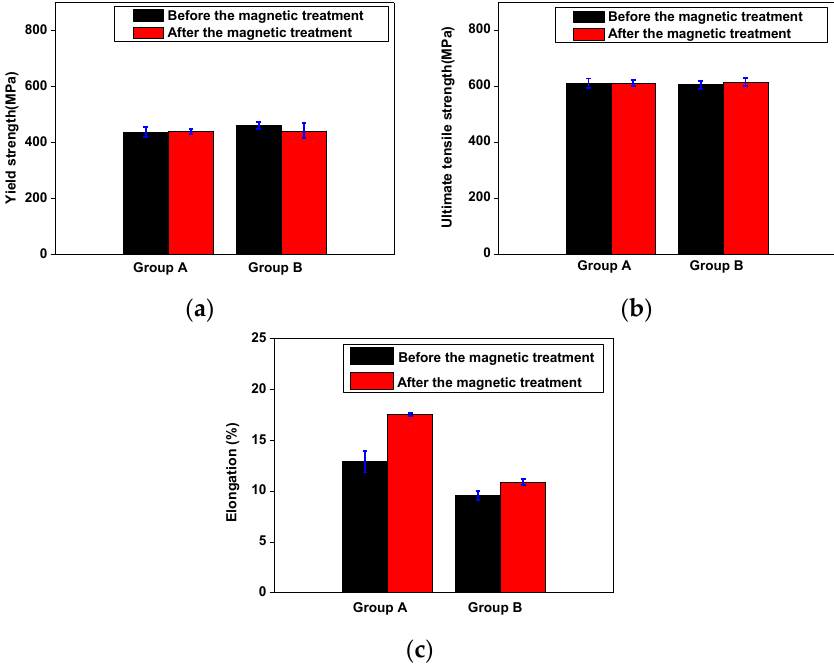
Figure 5. Mechanical properties before and after magnetic treatment: ( a ) yield strength; ( b ) ultimate tensile strength; and ( c ) elongation. Groups A and B represents the samples in large and small sizes, respectively. The blue line segments denote the standard deviation of measured data of three samples in each case.